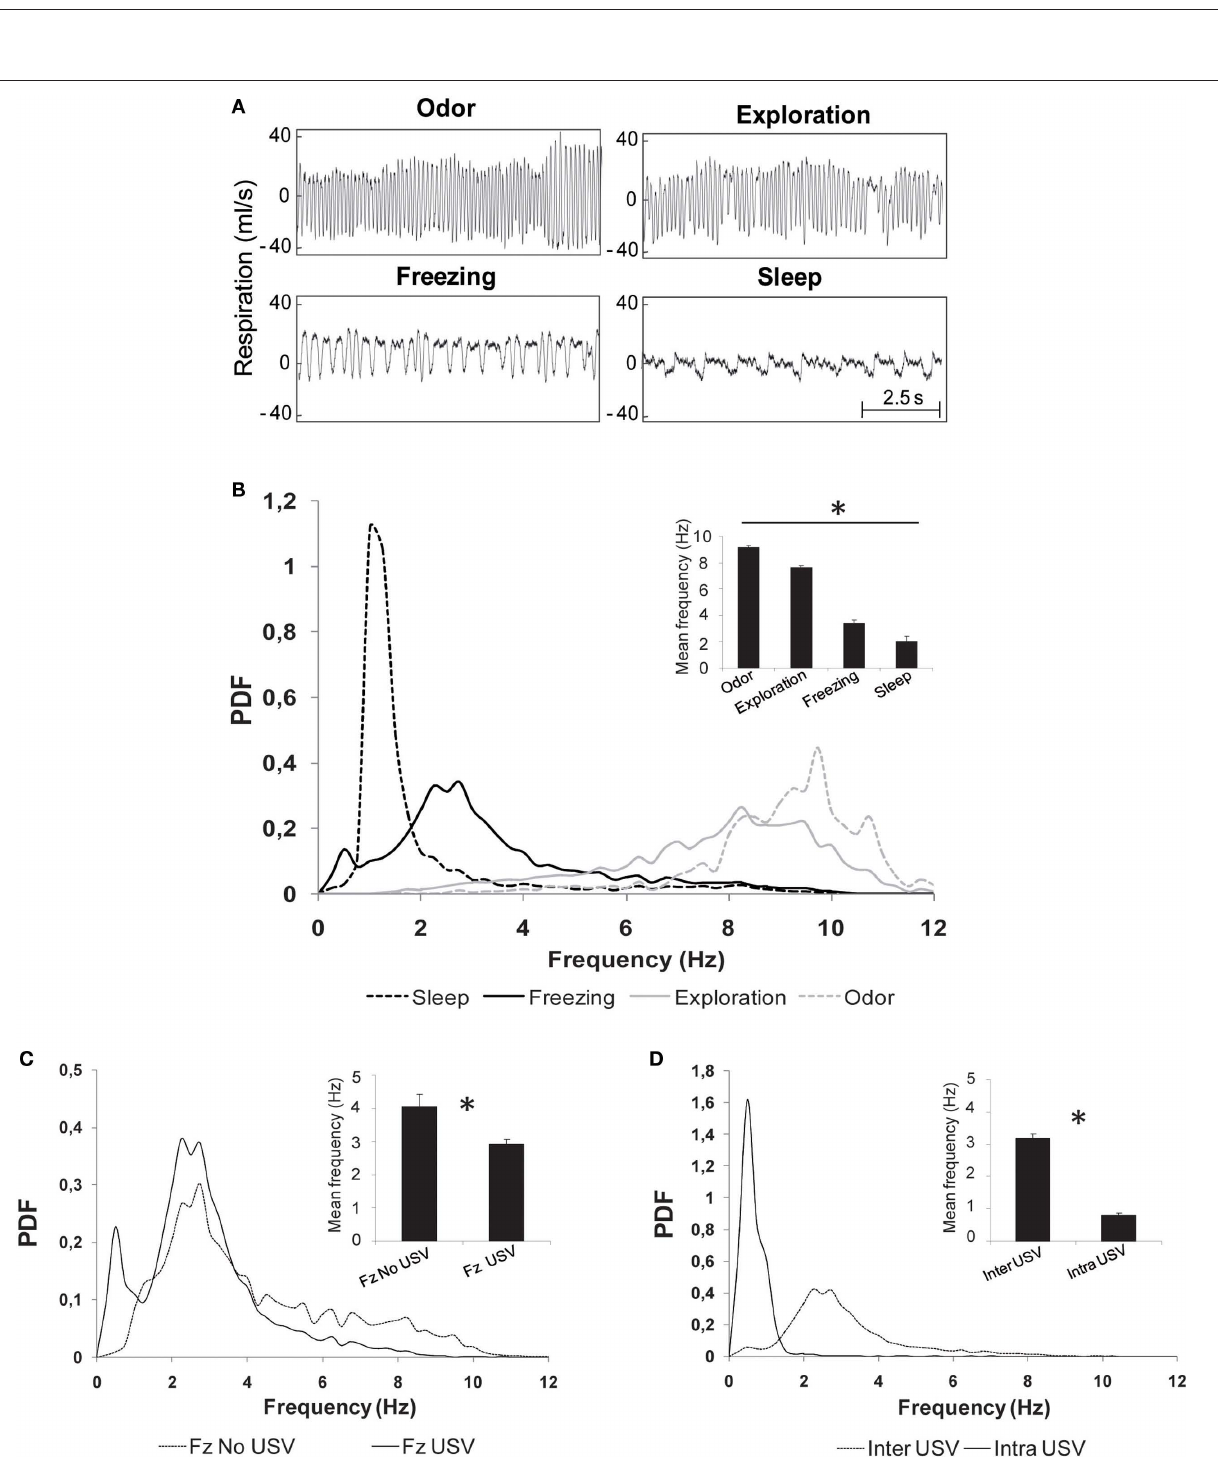
( p < 0.001). (C) Distribution of respiratory frequencies during freezing in two subgroups: animals emitting USV (Fz USV) and animals emitting no USV (Fz no USV). Insert : mean ± SEM frequency for each subgroup. *Significant differences between the two values ( p < 0.01). (D) Distribution of respiratory frequencies during call emission (intra-USV) or between calls (inter-USV). Insert : mean ± SEM frequency for each period. *Significant differences between the two values ( p